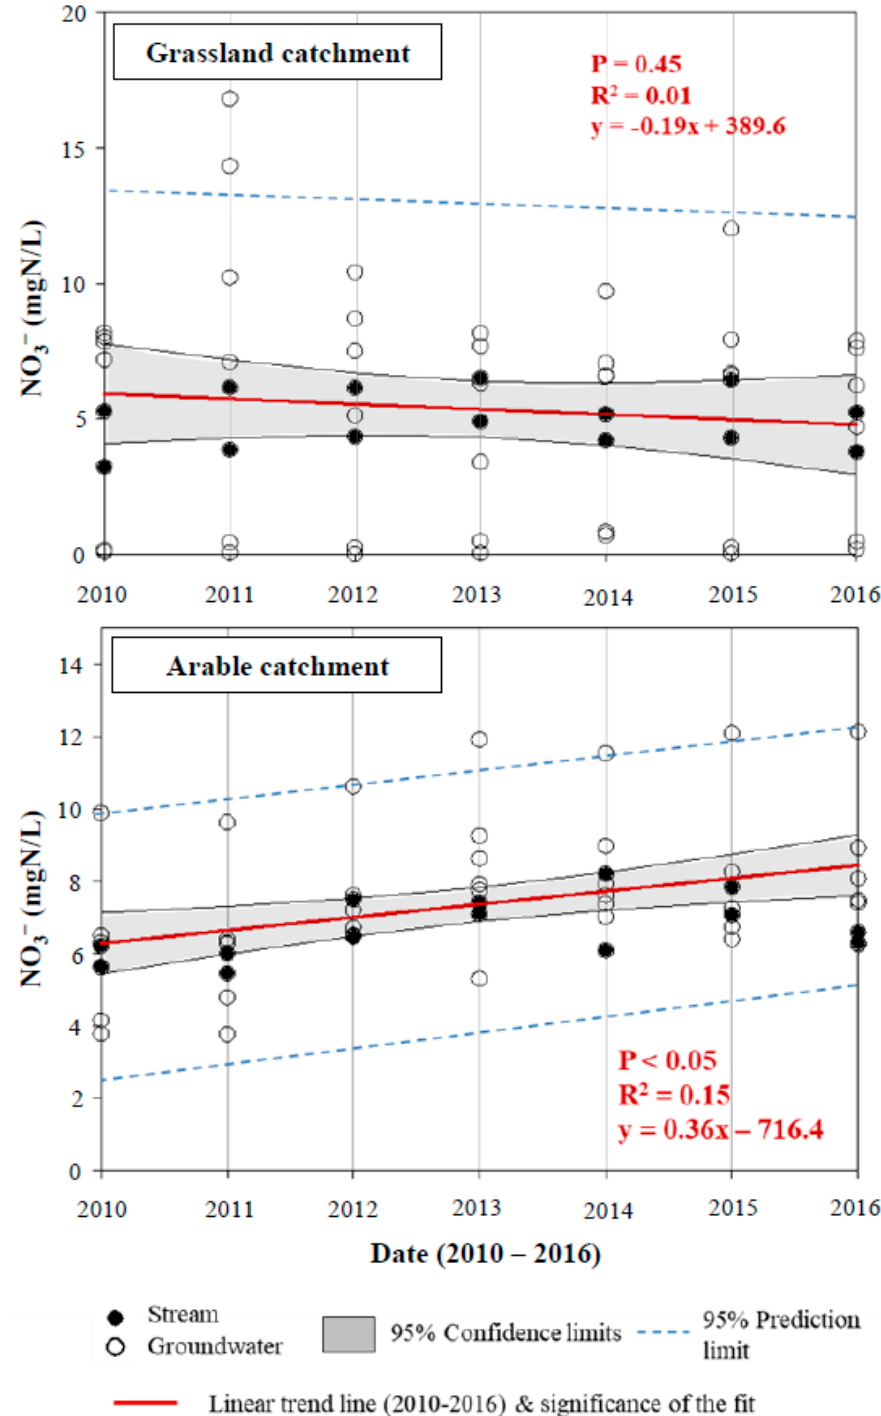
Figure 3. Grassland and arable catchment groundwater NO 3 − trends over time (2010 to 2016). The grassland catchment trend analysis includes all data from both the Grassland N and Grassland S hillslopes. The arable catchment trend analysis includes all data from both the Arable N and Arable S hillslopes. Open circles signify the mean annual groundwater NO 3 − concentration for each piezometer. Closed black circles represent the mean annual stream NO 3 − at the base of each hillslope. The trend line signifies the mean catchment NO 3 − concentration over time with the grey area representing the 95% confidence limits and the dotted lines signifying the 95% prediction limits.